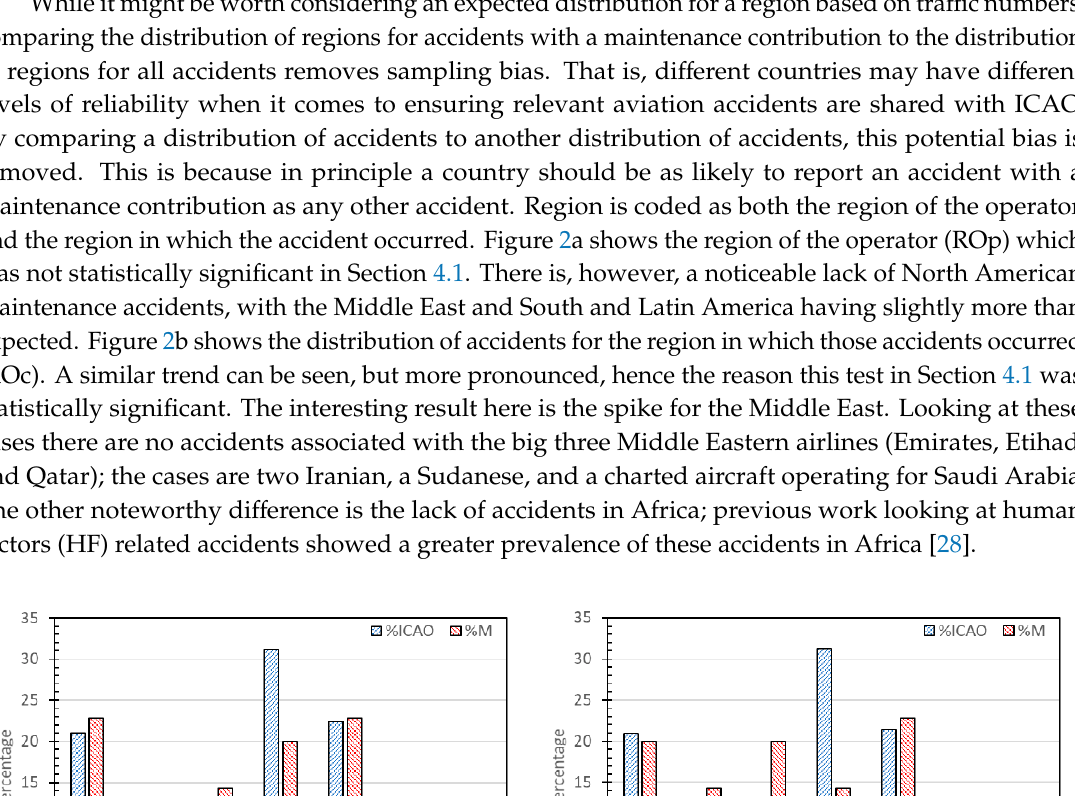
( b ) Figure 3. Distribution of phase of flight for accidents with maintenance contributions: ( a ) the phase in which the accident occurred (end result); ( b ) the phase in which the maintenance issue manifested.